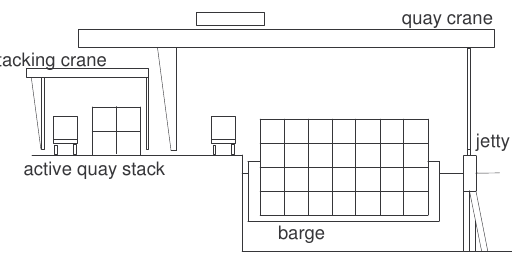
Figure 3. Profile of a Ship Service Station with Active Quay